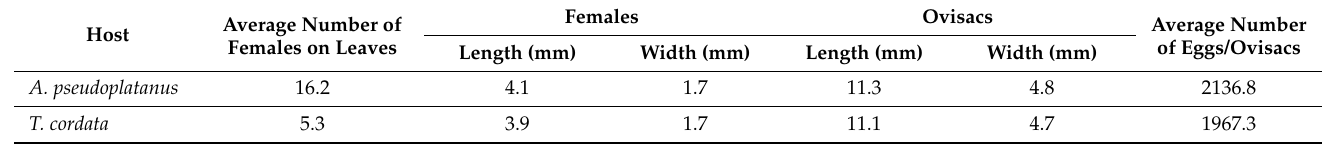
of Eggs/OvisacsLength (mm) Width (mm) Length (mm) Width (mm)